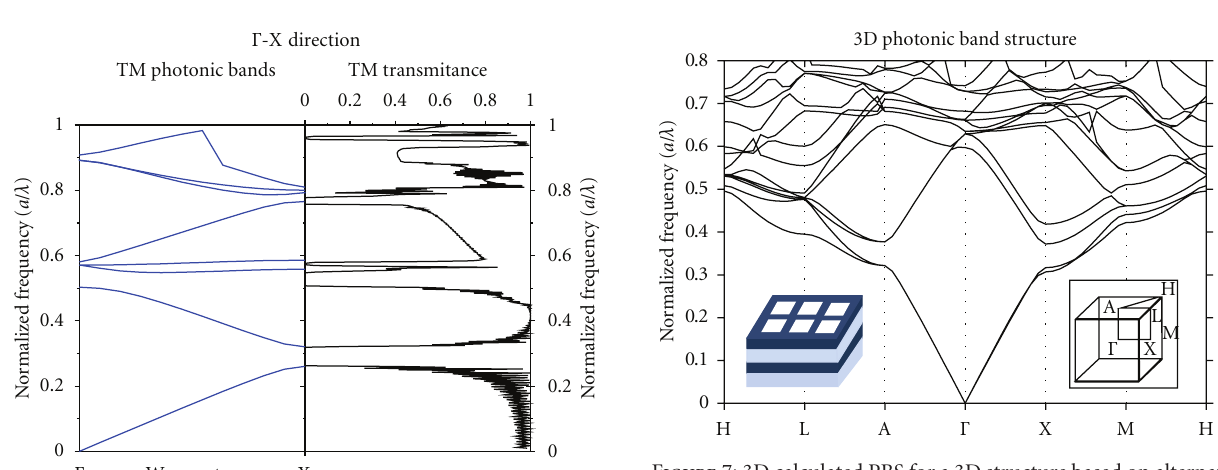
Figure 7: 3D calculated PBS for a 3D structure based on alternating Psi layers of 40 and 80% porosity and 0 . 5 a thickness each. Bands are plotted along main symmetry lines of the Brillouin zone, where frequency is given in normalized units ( a/λ ). Left inset, the schematic representation of 3D structure used in the simulations is represented. In dark blue the low-porosity Psi layers and in light blue the high-porosity Psi layers are shown. Right inset, the repre- sentation of 3D Brillouin zone is